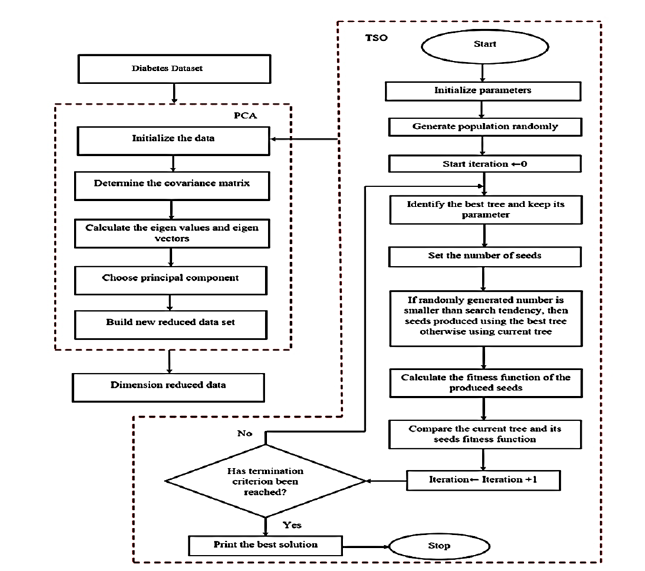
Figure 1. Overall diagram of the proposed